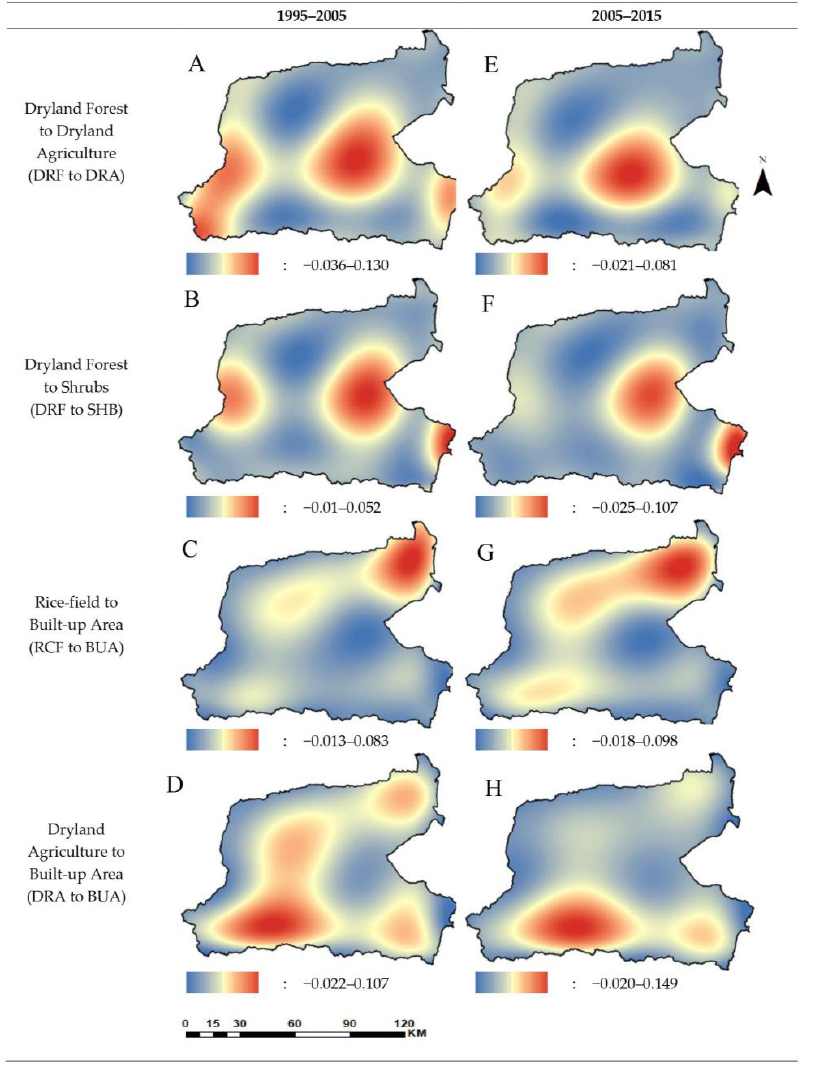
Figure 7. Spatial patterns of deforestation and urbanization for 1995 – 2005 ( A – D ) and 2005 – 2015 ( E – H